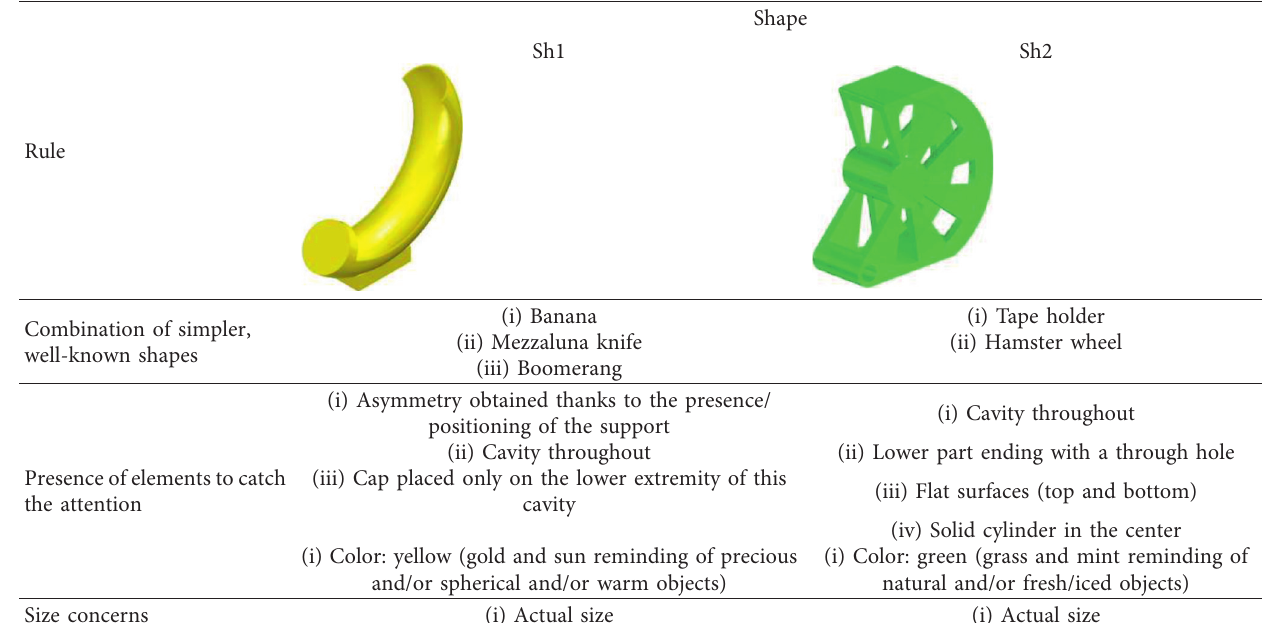
Table 3: Characteristics of the shapes used to fill the DA